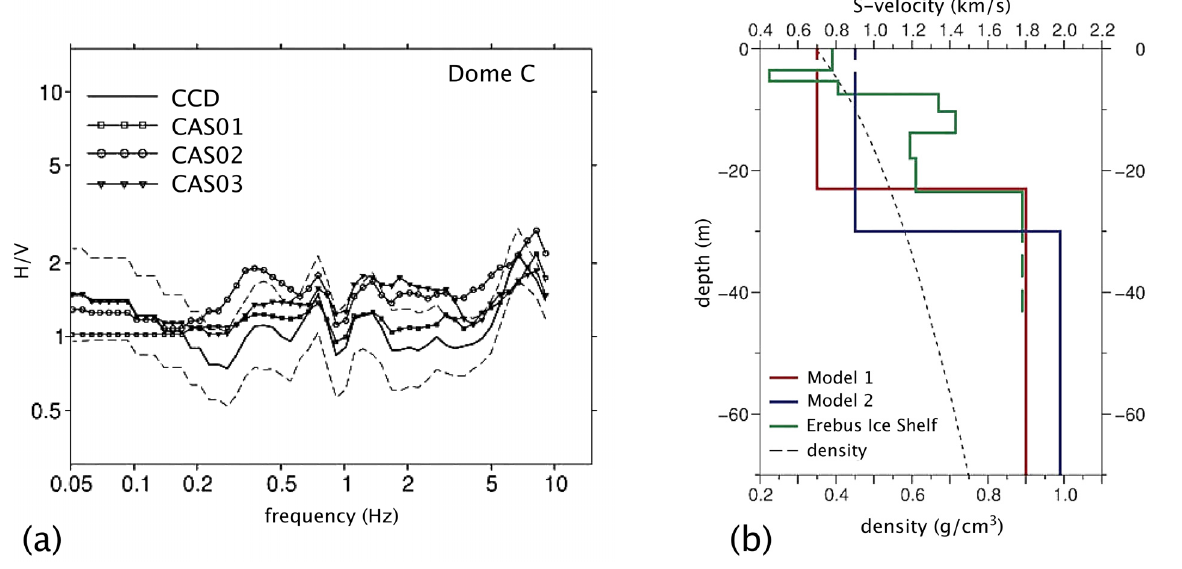
Figure 9. Snow structure at Dome C (after Lévêque et al. [2010]). (a) Mean spectral ratios of horizontal to vertical motion determined from noise at the four Dome C stations. The 1-sigma confidence level is similar for the different curves, and is shown for CCD only (dashed line). (b) S-wave velocity models. Model 1 is preferred, as it is the most compatible with the density profile at Concordia (L. Arnaud, personal communication